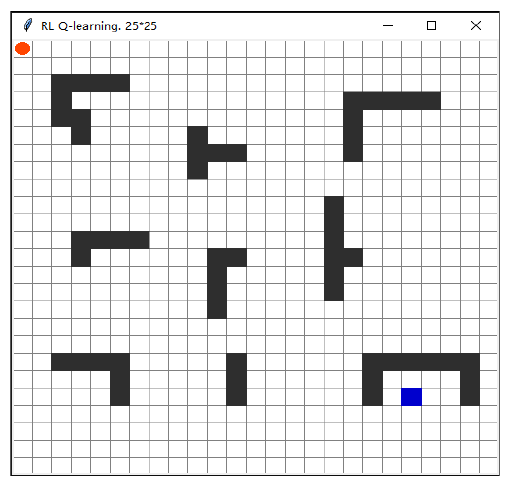
Figure 4. The 25 × 25 simulation grid obstacle environment.